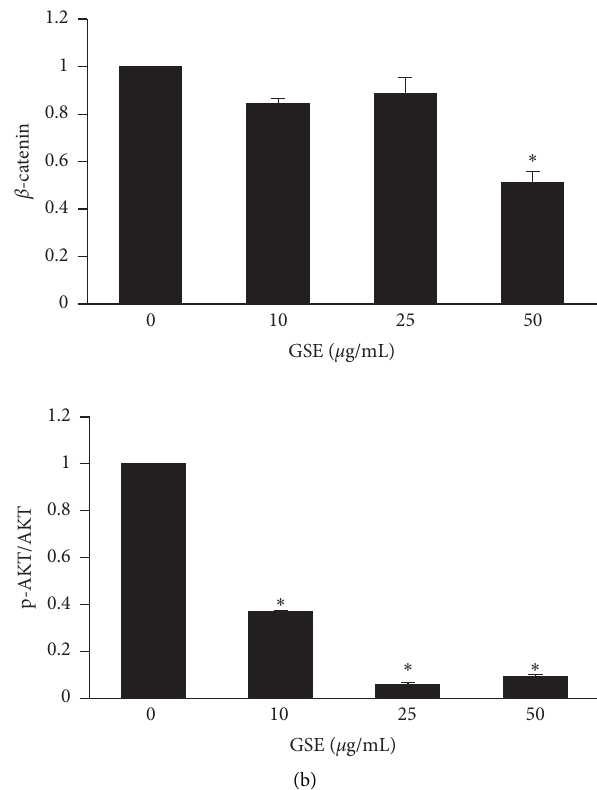
Figure 3: Suppression of survival-associated proteins by GSE. (a) MCF-7 cells were treated with GSE at 0–50 μ g/mL for 48h, and the expression of β -catenin, phosphorylated AKT (p-AKT), and total AKTwas measured using western blot analysis. (b) Relative protein levels were analyzed by densitometry. Data represent the mean ± SD ( n � 3). ∗ Significantly different at p < 0 . 05 versus nontreated